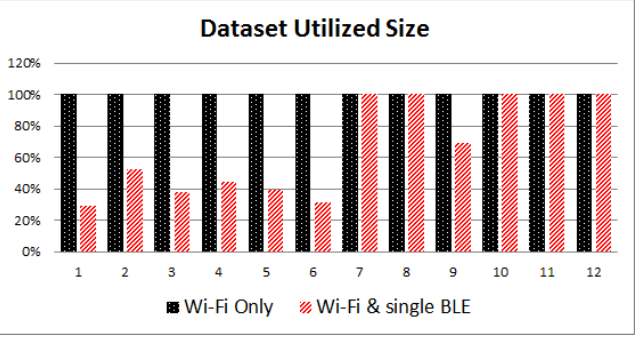
Figure 5. Fingerprint dataset size utilization: Wi-Fi only vs. single BLE and Wi-Fi.